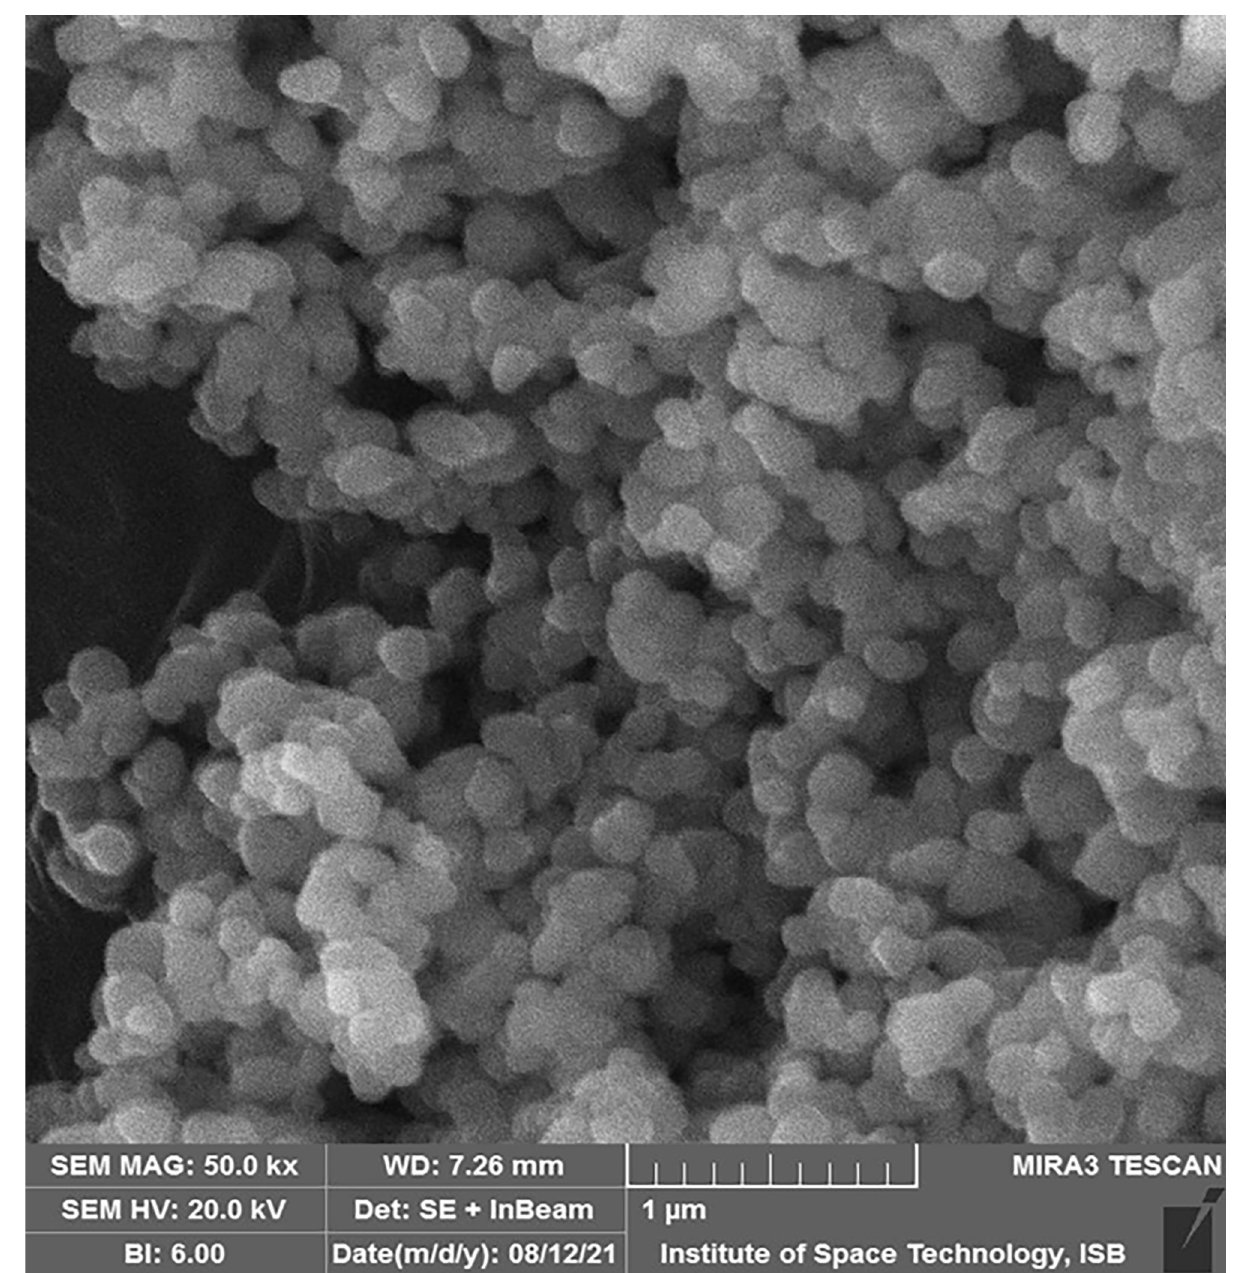
Fig 2. Scanning electron microscope (SEM) analysis of the green synthesized